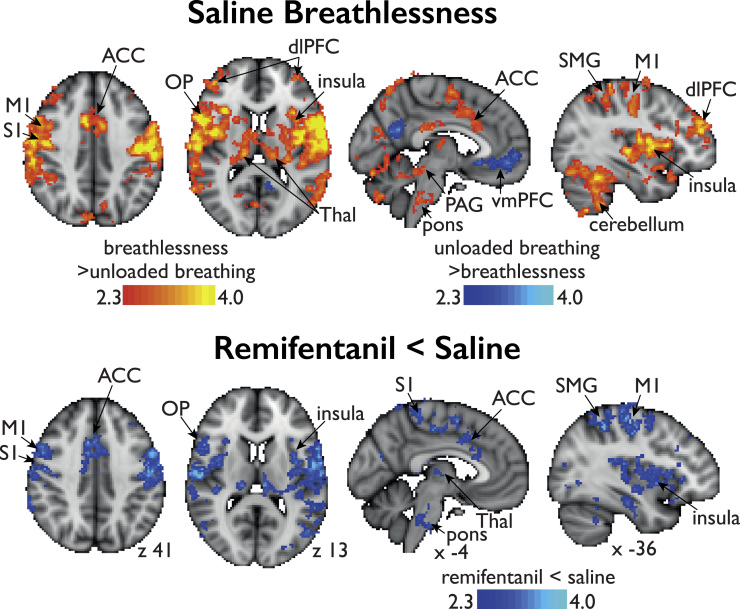
BOLD activity during the breathlessness condition during saline (placebo) infusion (top figure) and the effect of remifentanil infusion (lower figure). The image consists of a color-rendered statistical map superimposed on a standard (MNI) brain. Significant regions are displayed with a threshold of Z>2.3 and a cluster probability threshold of p<0.05 (corrected for multiple comparisons). Abbreviations: dlPFC, dorsolateral prefrontal cortex; OFC, opercular-frontal cortex (operculum); ACC, anterior cingulate cortex; M1/S1 primary motor and sensory cortices; SMG, supramarginal gyrus; Thal, thalamus.